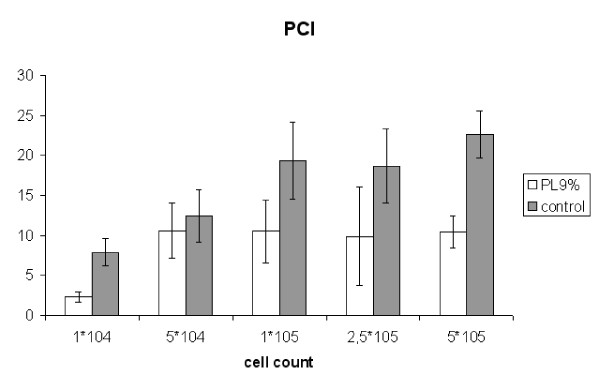
Experiment B: Peritoneal Cancer Index (PCI, SEM). (1*104 p = 0,001; 5*104 no significance; 1*105 p = 0.007; 2,5*105 p = 0.001; 5*105 p = 0.0011)